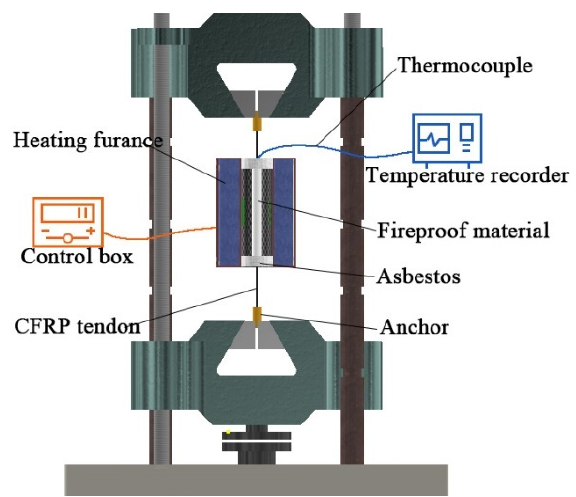
Figure 9. Specimen of fire resistance test.